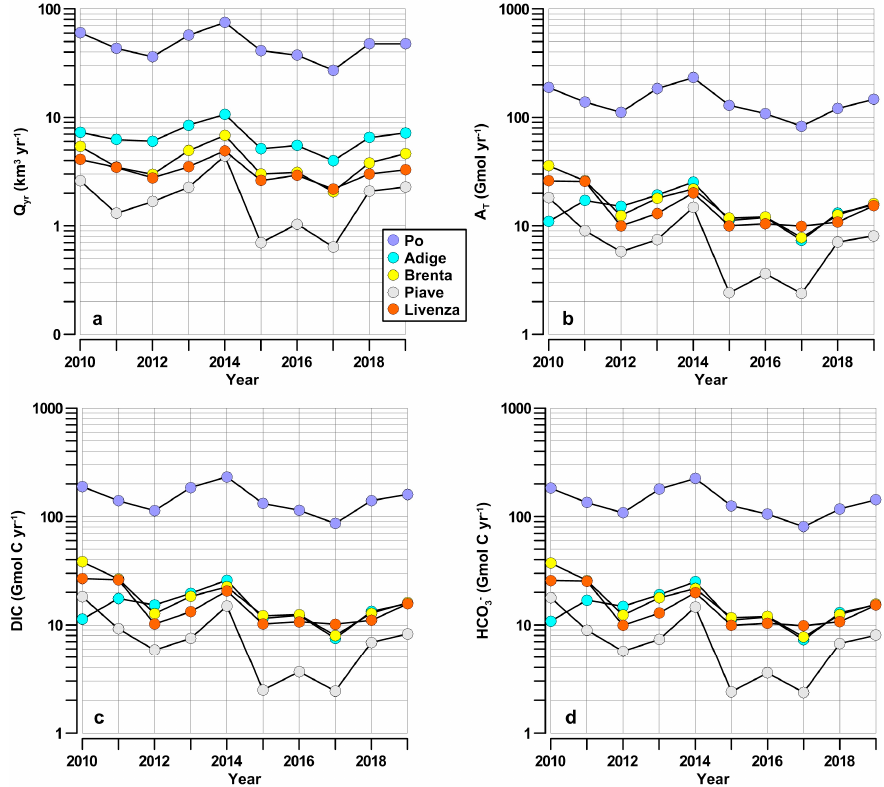
Figure 7. Annual discharges of ( a ) river water (Qyr; km 3 yr − 1 ), ( b ) total alkalinity (A T ; Gmol yr − 1 ), ( c ) dissolved inorganic carbon (DIC; Gmol C yr − 1 ) and ( d ) bicarbonate (HCO 3 − ; Gmol C yr − 1 ) in the northern Adriatic by major rivers, in 2010–2019.